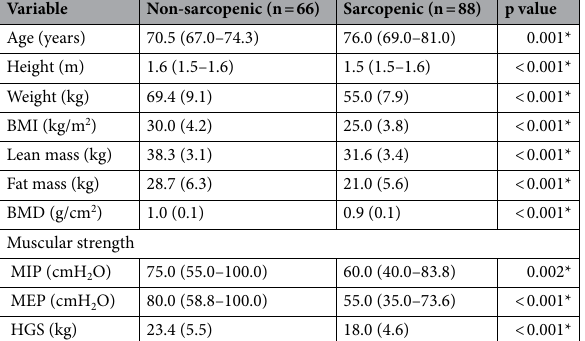
Table 1. Comparison of anthropometrics, body composition characteristics, and physical tests between groups. Data presented as mean ± SD or median (interquartile range). BMI body mass index, BMD bone mineral density, MIP maximal inspiratory pressure, MEP maximal expiratory pressure, HGS hand grip strength.*p < 0.05.